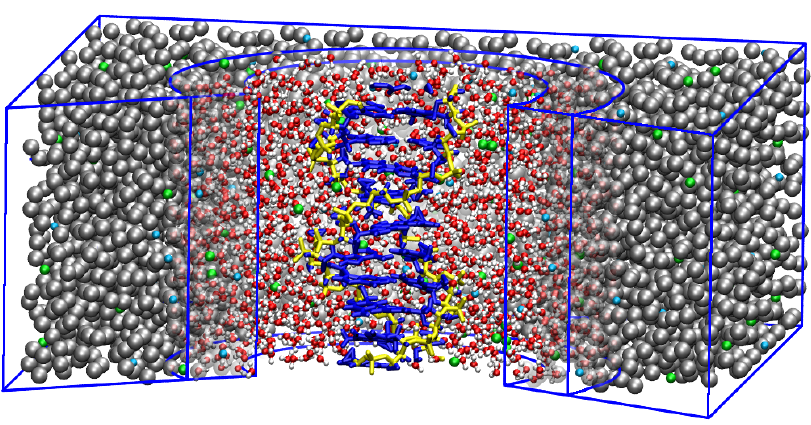
Figure 1. An atomistic DNA molecule embedded in a dual-resolution salt solution. The proximal solvent around the DNA molecule is modeled using the atomistic level of detail whereas the distal water molecules are represented as grey beads, i.e., one bead corresponds to one water molecule. The salt ions are shown in green (Na + ) and blue (Cl − ). Reprinted (adapted) with permission from Ref. [70]. Copyright (2015) American Chemical Society.